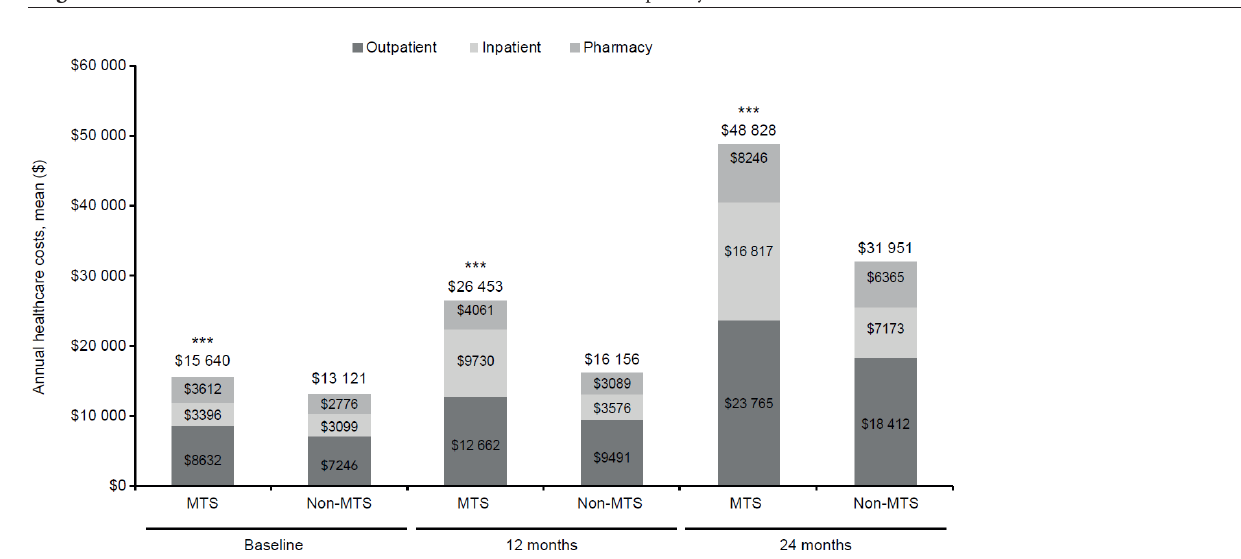
Figure 3. Direct Medical Costs at Baseline, 12, and 24 Months in Propensity Score–Matched OA Pain Cohorts